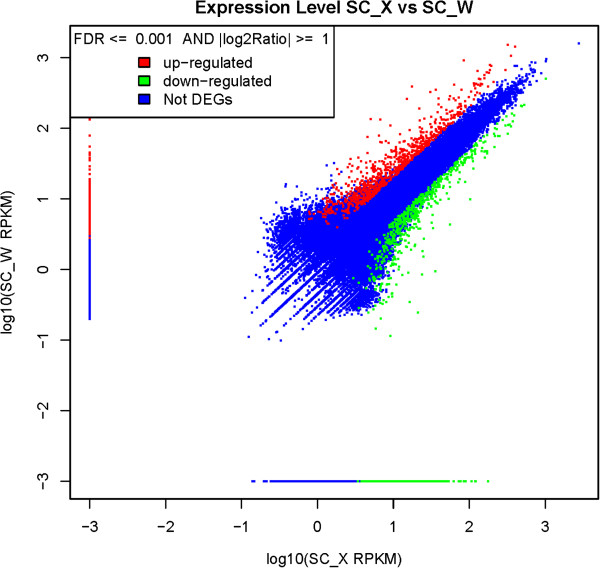
Scatter plot showing the correlation between the expression levels of feeders and nonfeeders by transcriptome sequencing. SC_X and SC_W indicate feeders and nonfeeders, respectively. The x-axis contains Log10 of Reads Per Kb per Million reads (RPKM) of feeders and the y-axis indicates Log10 of RPKM of nonfeeders. Limitations were based on FDR ≤ 0.001, and the absolute value of Log2 (SC_X / SC_W) ≥ 1.